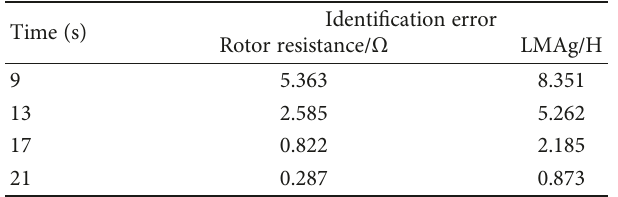
Figure 10: Hardware test connection diagram. Table 1: Convergence of identi fi cation